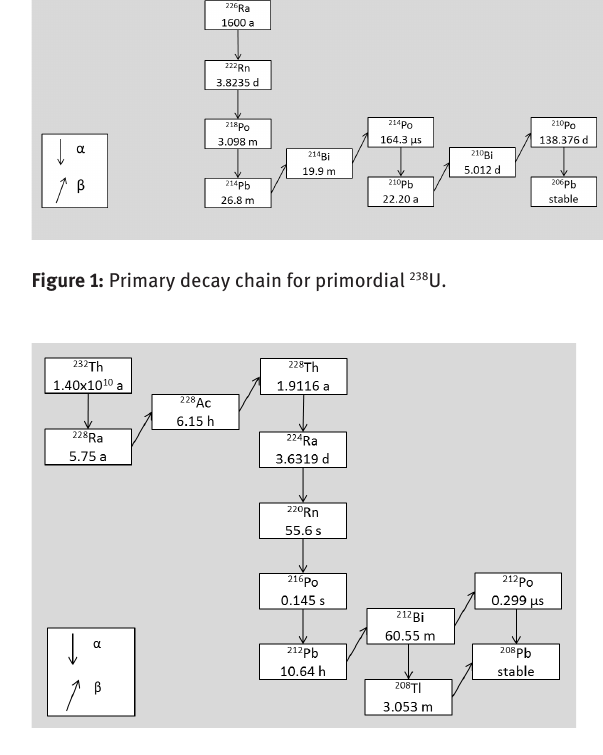
Figure 2: Primary decay chain for primordial 235 U.